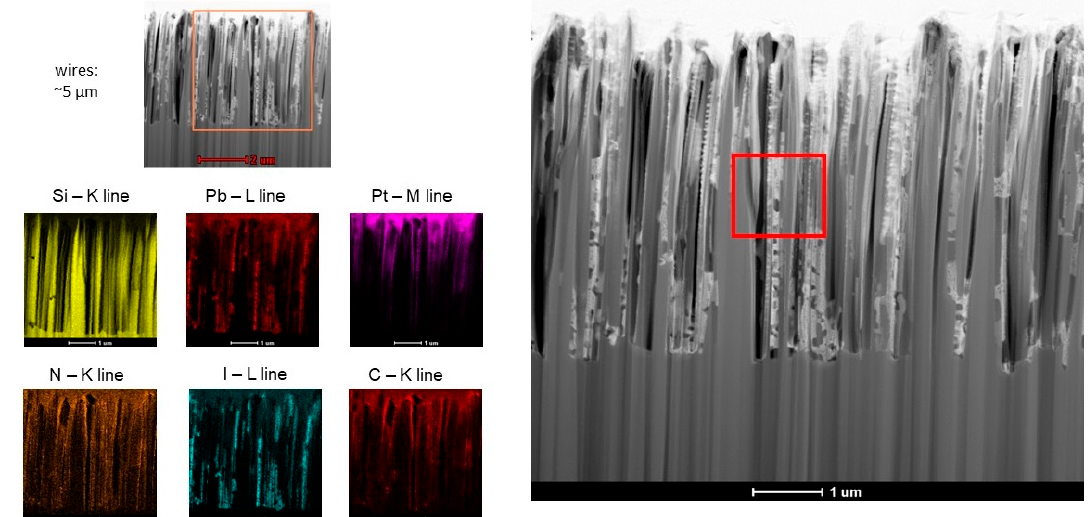
Figure 8. TEM image of silicon wafer with wires etched by MAE for 5 min with the perovskite layer obtained in a two-step deposition process. In colors, the presence of elements is marked.